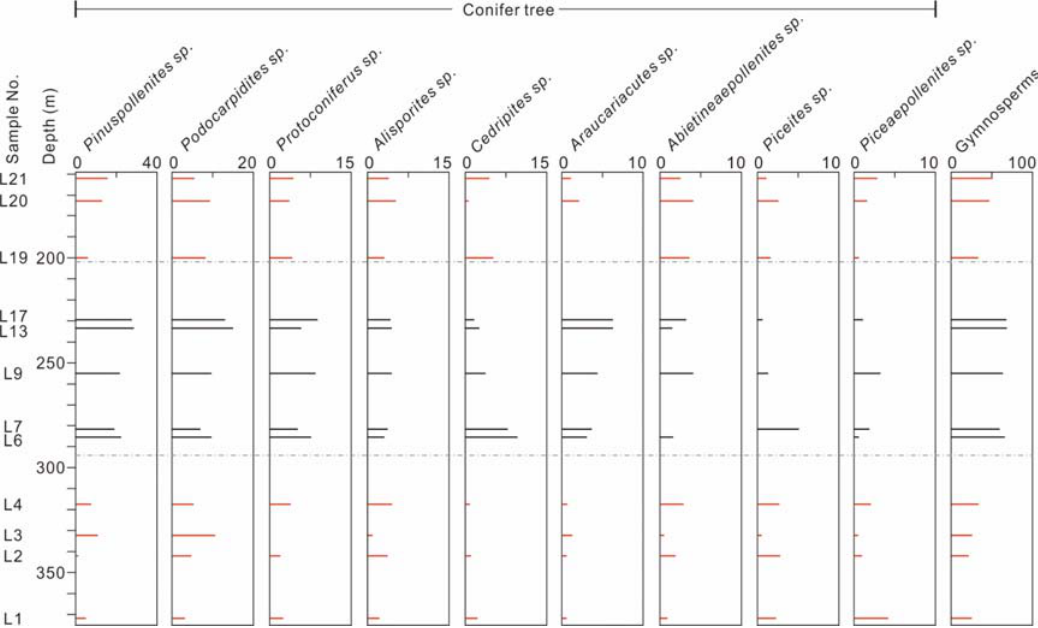
Figure 8. Percentages of major pollen in oil shale and coal. The red bar represents oil shale, and the black bar represents coal. The two horizontal grey lines show the boundaries of the three units.